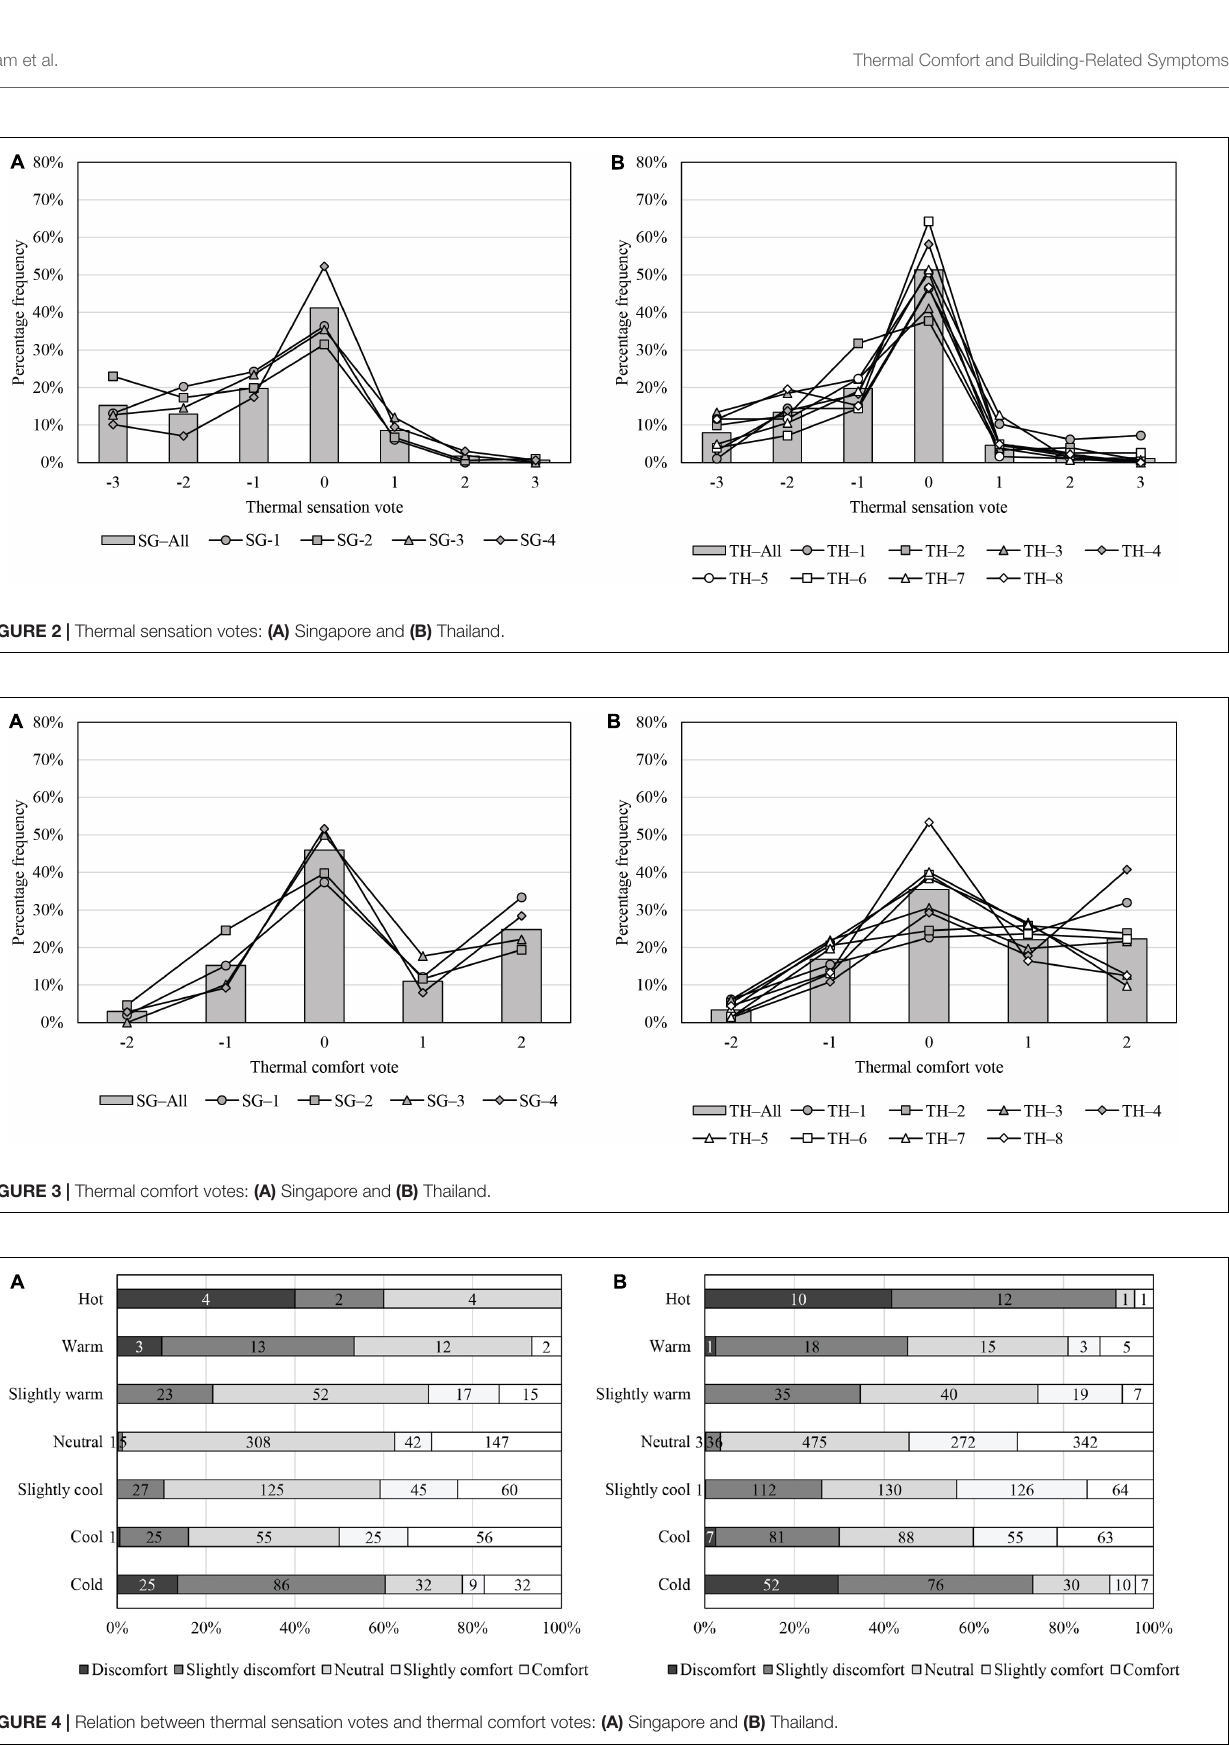
Frontiers in Built Environment |